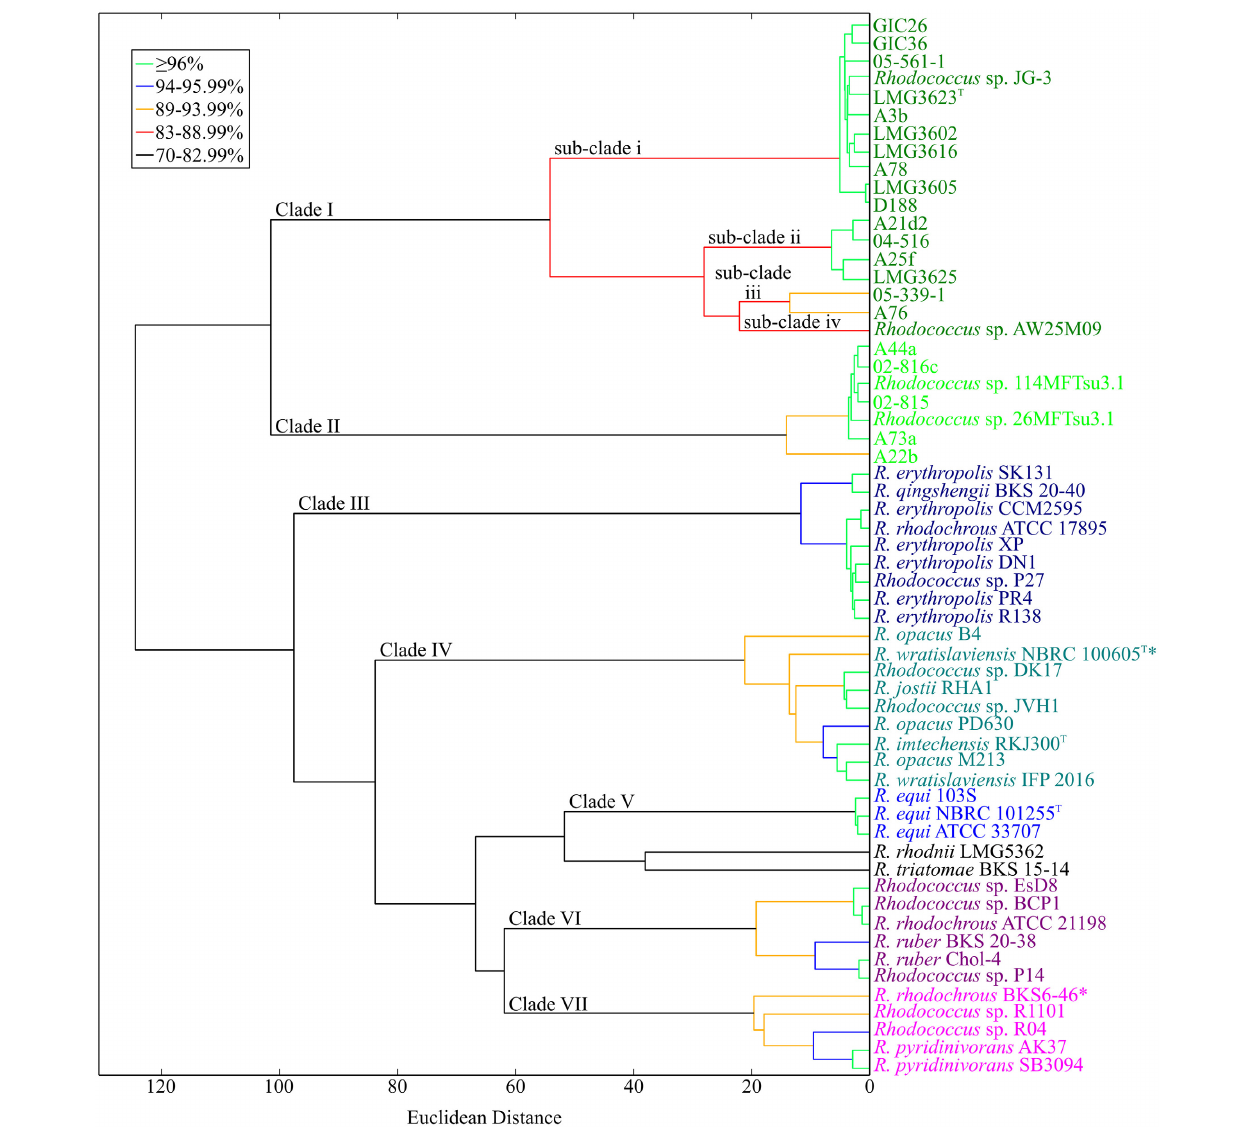
nodal point. The 21 Rhodococcus isolates sequenced by our group are shown in bold; type strains are designated with a superscript “T.” Clades and sub-clades of the phytopathogenic Rhodococcus isolates are labeled at the corresponding node. ∗ Indicates conflict between placement within the dendogram and calculated ANI values (see corresponding text for